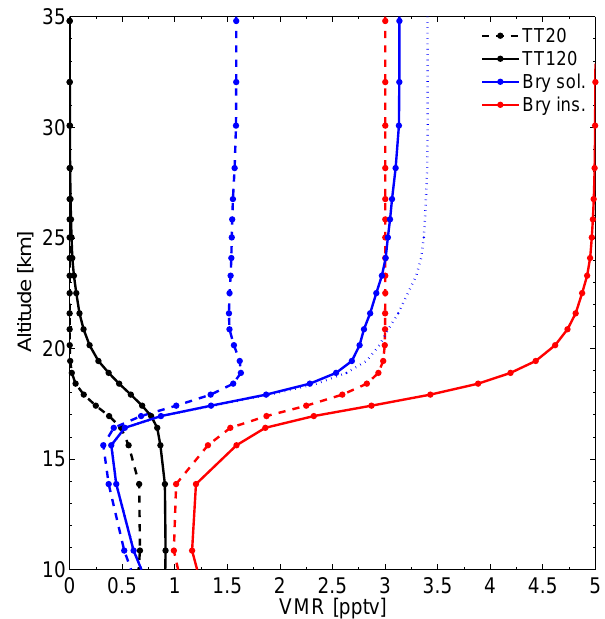
Fig. 3. Averaged tropical profiles (20 ◦ N to 20 ◦ S) of TT20 (CHBr 3 ), TT120 (CH 2 Br 2 ) and soluble and insoluble Br y for 2006. The dashed profiles of soluble/insoluble Br y resulting from a setup where TT20 is the only brominated source gas (as in Aschmann et al., 2009) whereas the solid profiles denote the model run with both TT20 and TT120. The assumed detrainment mixing ratio for both VSLS is 1pptv. The dotted blue profile marks soluble Br y from a sensitivity run where washout of Br y is restricted to within 40 ◦ N to 40 ◦